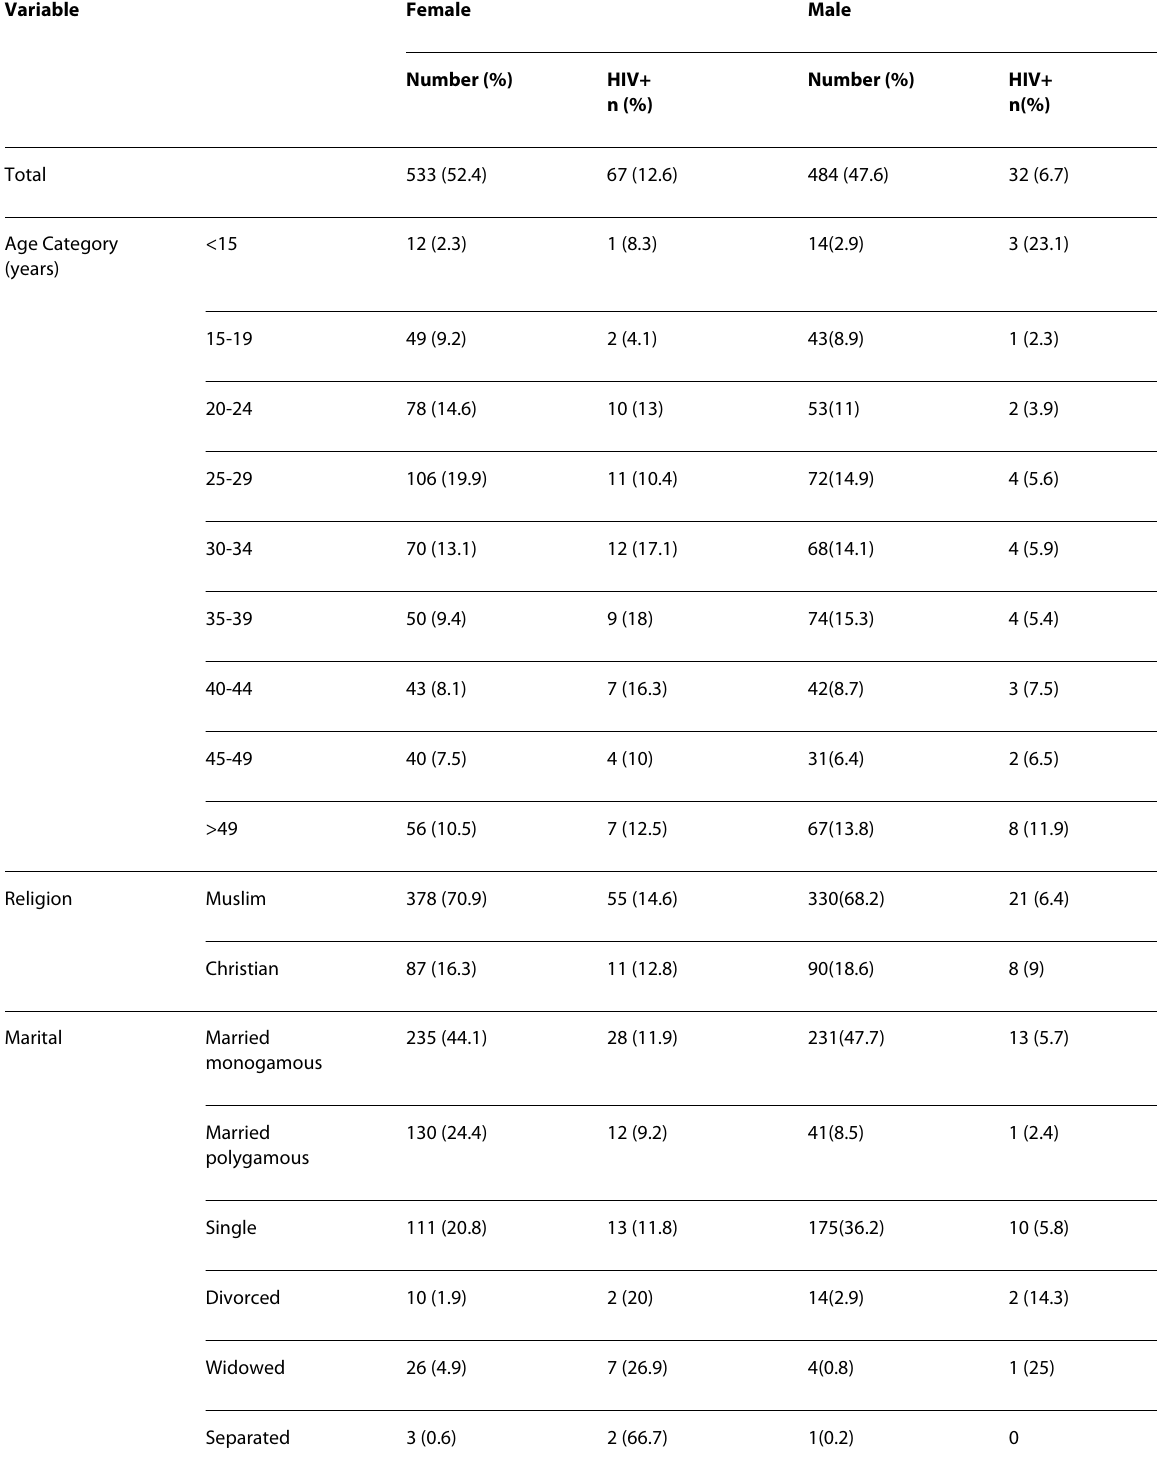
Table 2: Non-antenatal population: Characteristics and HIV prevalence, by sex